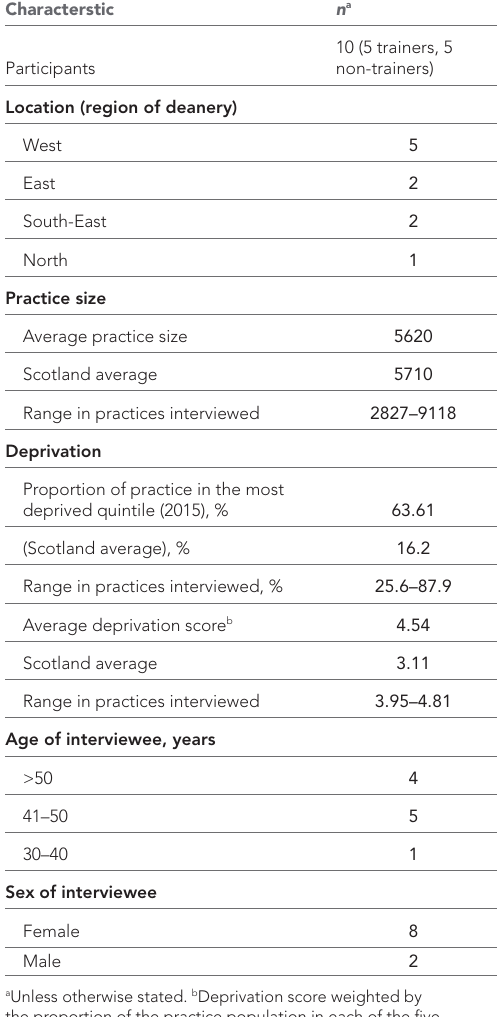
Table 2 Summary characteristics of study prac- tices and demographics of interviewees (with comparison, where relevant, to Scottish